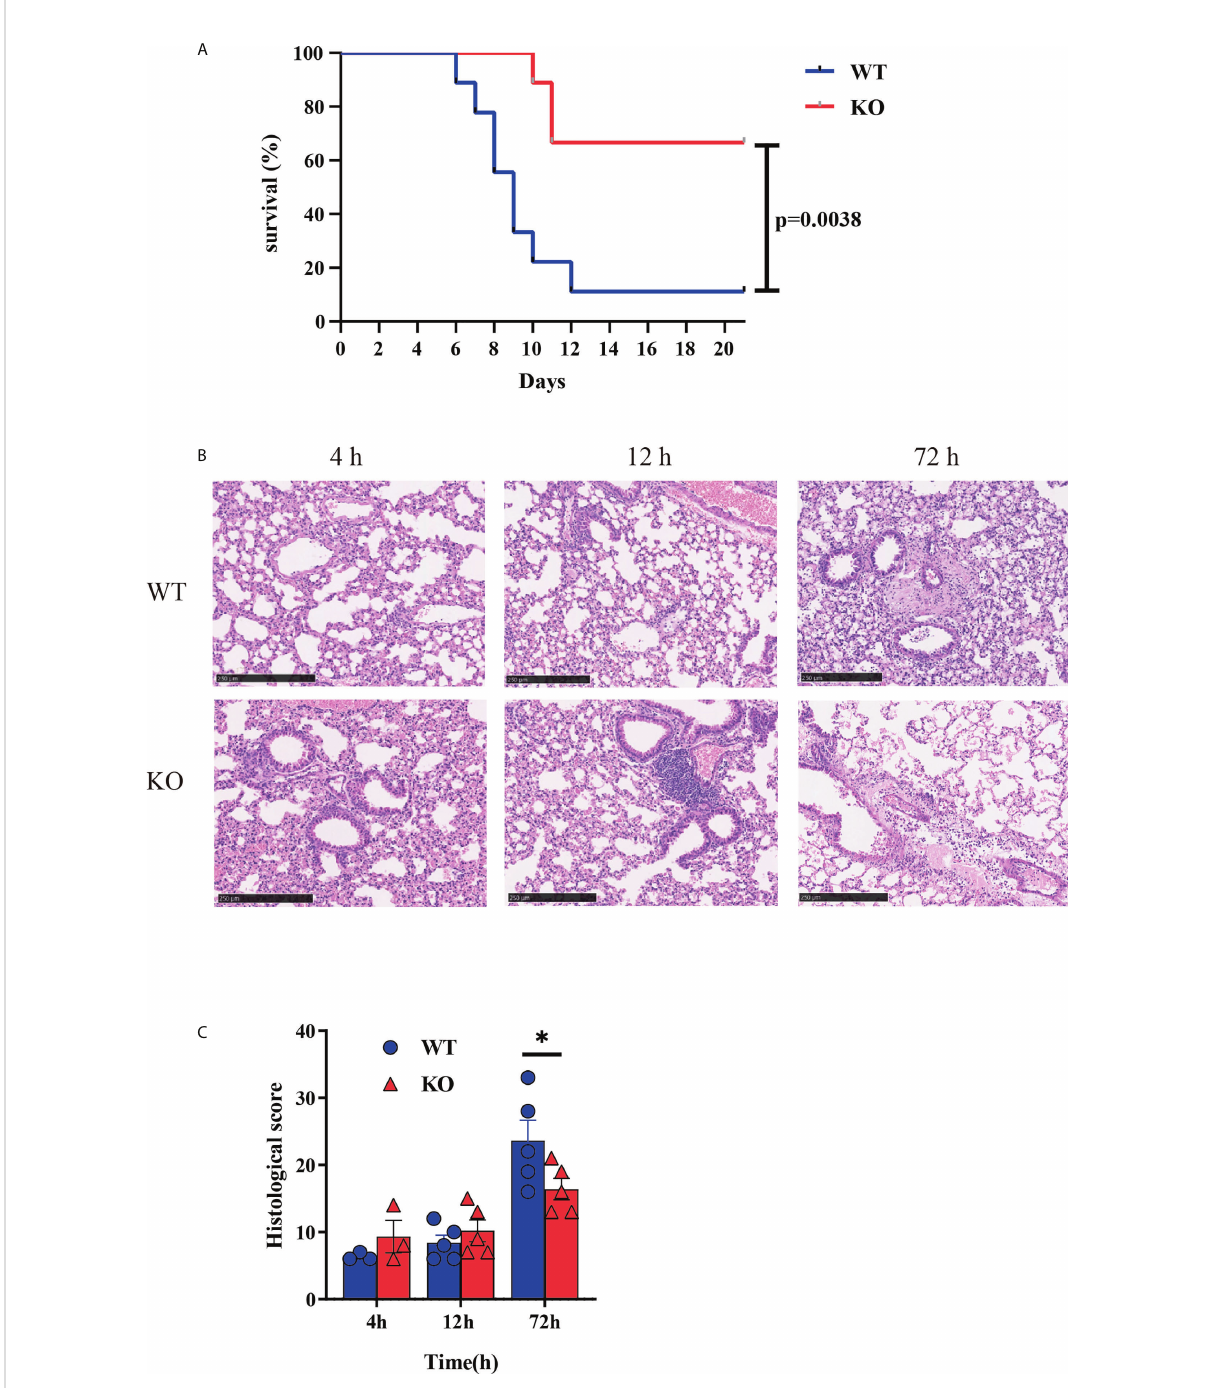
FIGURE 1 Csf2ra KO mice acquire protection from RT-induced mortality and morbidity. (A) Survival curves for Csf2ra KO mice (n = 10) and WT mice (n = 10); survival rate of the two groups is signi fi cantly different ( P = 0.0038). (B) H&E stained lung tissue from each treatment group at three time points. Scale bar, 250 m m. (C) Pathological score for each group. *P